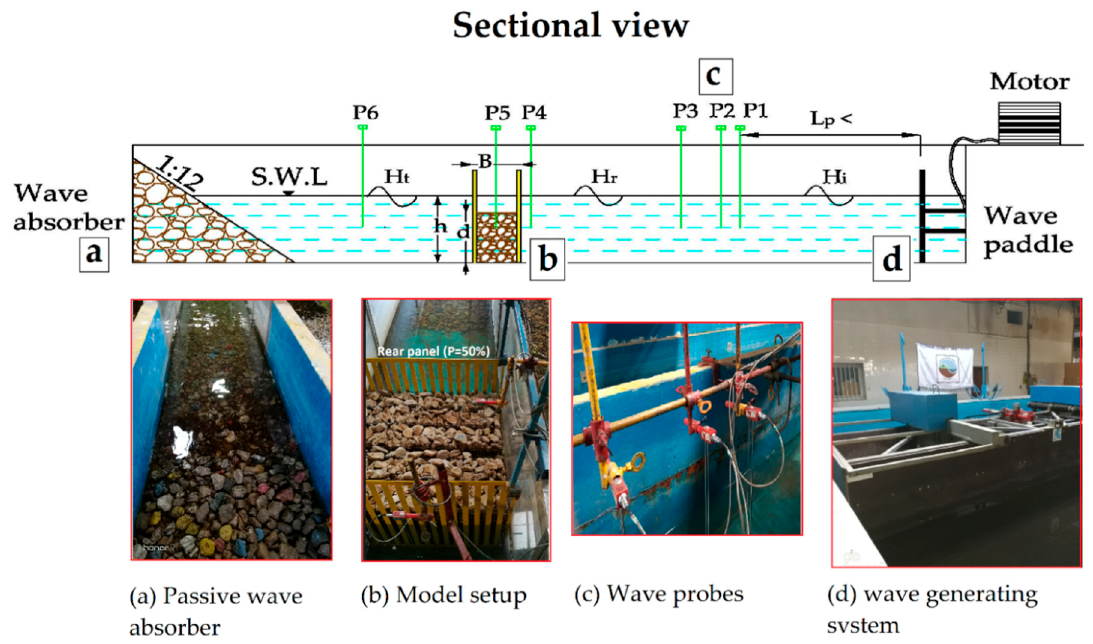
Figure 2. Details of wave flume, model position, and wave probes locations; ( a ) Passive wave absorber; ( b ) Model setup; ( c ) Wave probes; ( d ) Wave generating system